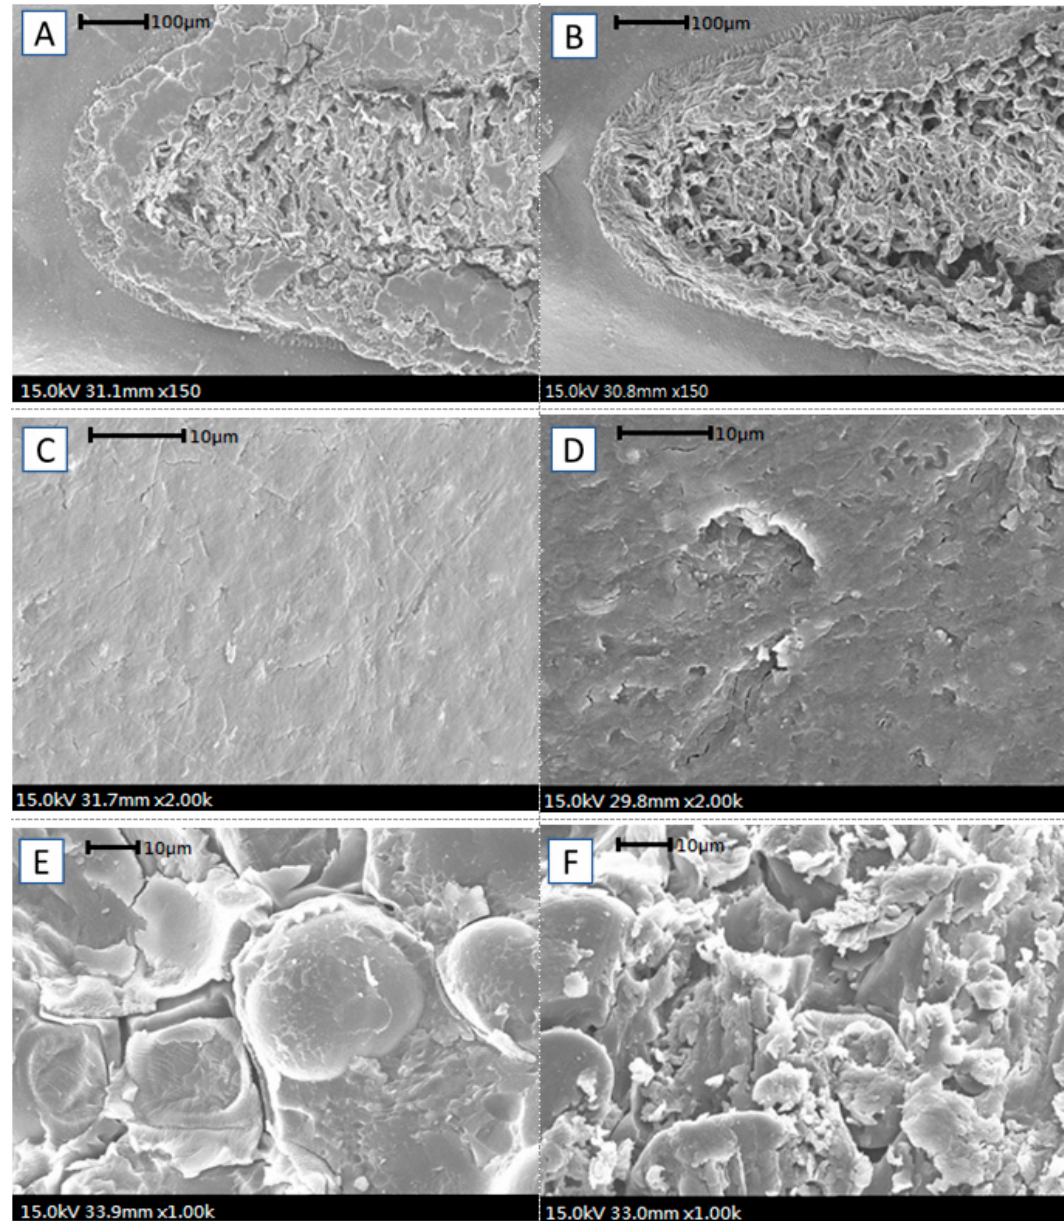
Figure 3. The microstructure of the hila, seed coat surfaces, and starch granules of adzuki bean seeds of two varieties: ( A ) hilum of Kaohsiung 8, non-treated control seed (1.5 kV, 150 X); ( B ) hilum of Kaohsiung 8, 80 kHz ultrasonication treated seed (1.5 kV, 150 X); ( C ) seed coat surface of Kaohsiung 8, non-treated seed (1.5 kV, 2.0 kX); ( D ) seed coat surface of Kaohsiunh 8, 80 kHz ultrasonication treated seed (1.5 kV, 2.0 kX); ( E ) starch granules of Kaohsiung 8, non-treated control seed (1.5 kV, 1.0 kX); ( F ) starch granules of Kaohsiung 8, 80 kHz ultrasonication treated seed (1.5 kV, 1.0 kX).